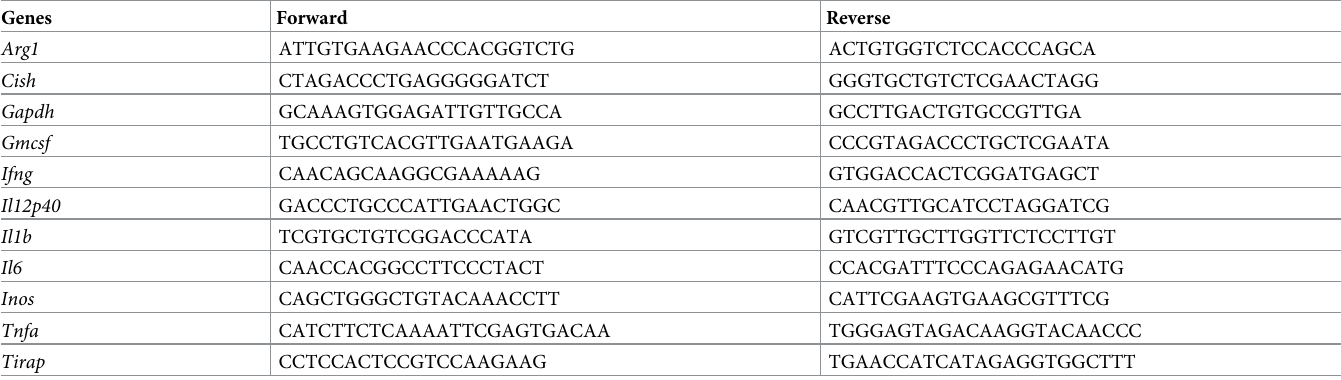
Table 2. Forward and reverse primers